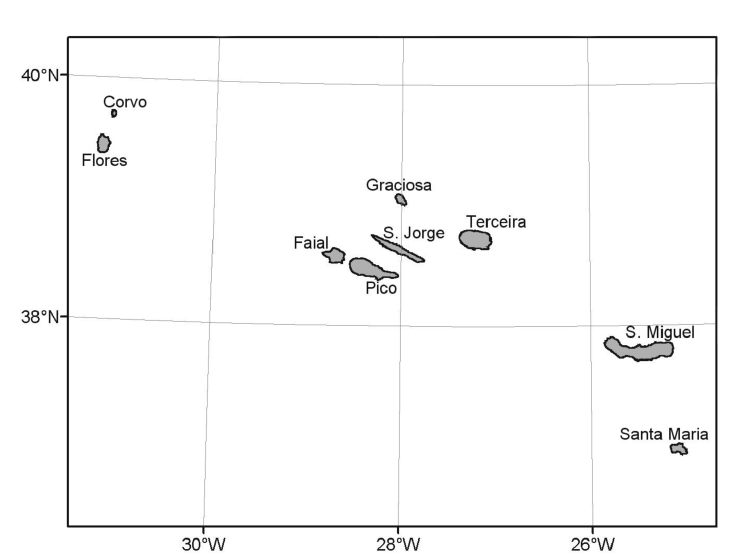
Fig. 1. Geographic location of the Azores